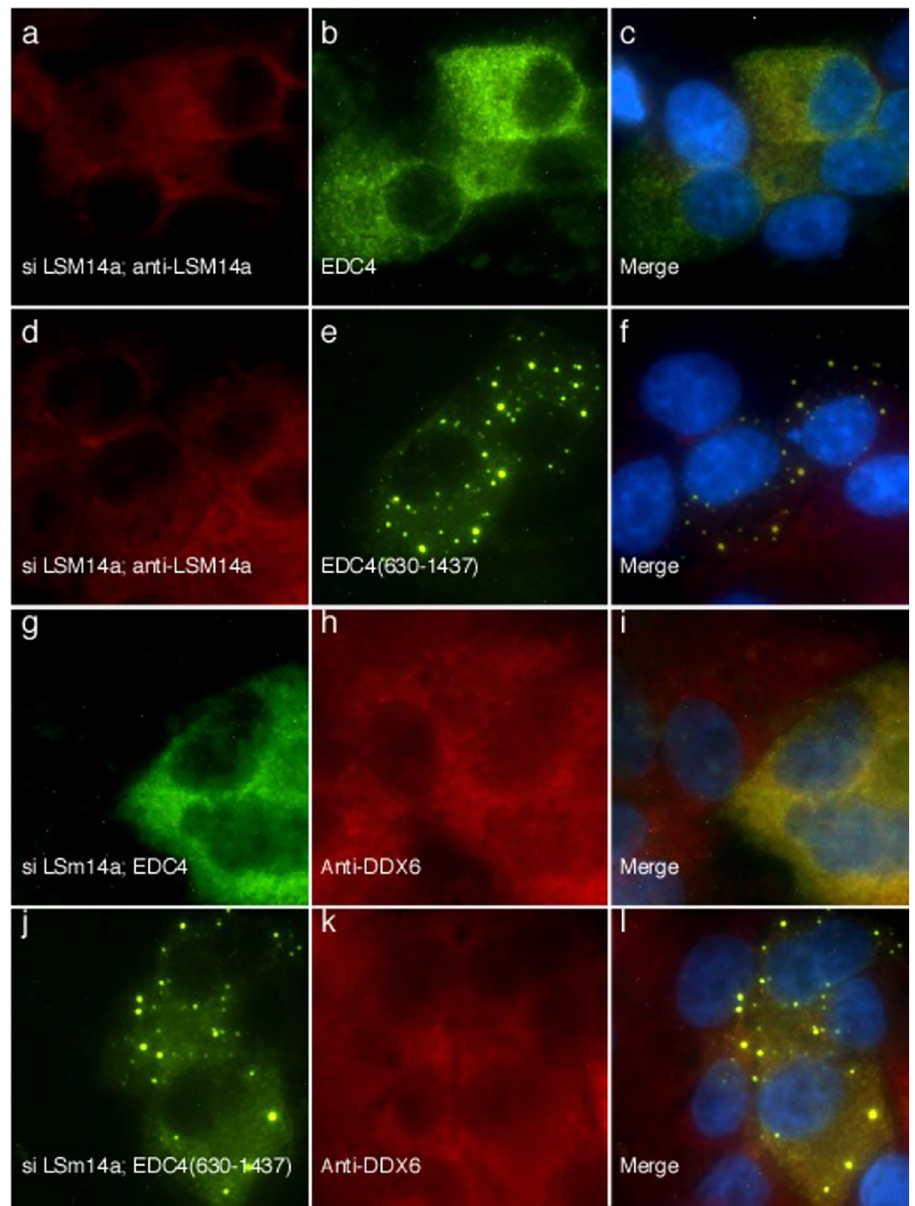
Fig 7. After depletion of LSm14a and loss of endogenous P-bodies, GFP-EDC4(630–1437), but not GFP-EDC4, localizes to cytoplasmic dots. siRNA directed against LSm14a was transfected into HEp-2 cells, followed 24 hours later by transfection of GFP-EDC4 or GFP-EDC4(630–1437). LSm14a was not detected in siLSm14a-treated cells (panel a). GFP-EDC4 (panels b, c) was unable to localize to P-bodies and was distributed throughout the cytoplasm of transfected cells. In cells depleted of LSm14a (panel d) and expressing GFP-EDC4(630–1437) (panels e, f), GFP-EDC4 (630–1437) was detected in cytoplasmic dots that were indistinguishable from P-bodies at the level of UV light microscopy. After disruption of endogenous P-bodies, neither full-length EDC4 nor EDC4(630–1437) was able to recruit DDX6 to cytoplasmic dots. After depletion of LSm14a using siRNA, GFP-EDC4 (panel g) did not form cytoplasmic dots and was unable to recruit endogenous DDX6 (panel h) to cytoplasmic dots. After depletion of LSm14a, GFP-ED4(630–1437) (panel j) was able to form cytoplasmic dots, but was unable to recruit endogenous DDX6 (panels k, l) to these structures. Rabbit antiserum was used to confirm the absence of LSm14a in a and d. Mouse anti-GFP antibodies detected GFP-EDC4 (b, g) and GFP-EDC4(630–1437) (e and j). Rabbit anti-DDX6 antiserum was used to detect endogenous DDX6 in h and k. Merge of panels a and b, d and e, g and h, and j and k is shown in c, f, i, and l, respectively. DAPI staining (blue) in c, f, i and l indicate the location of nuclei.